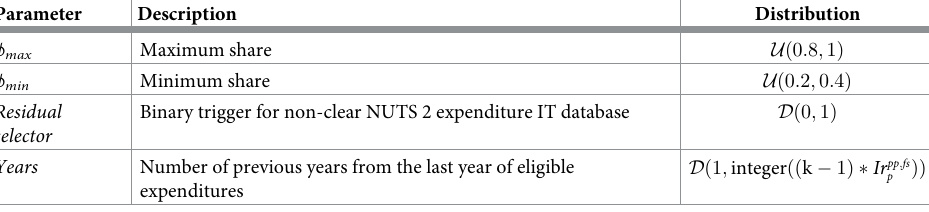
Table 1. Summary of parameters and their distribution. D and U indicate discrete and uniform, respectively. Parameter Description Distribution ϕ max Maximum share ϕ min Minimum share Binary trigger for non-clear NUTS 2 expenditure IT database D ð 0 ; 1 Þ Residual selector Years Number of previous years from the last year of eligible